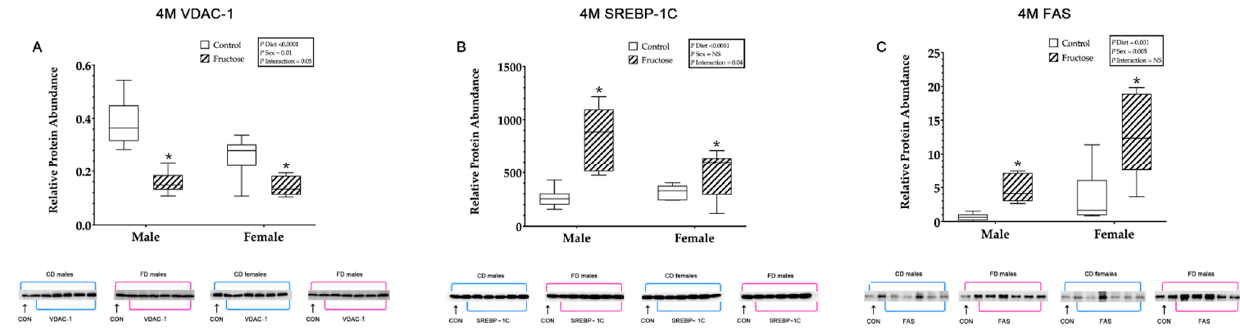
± 52.86 vs. FD males, 764.68 ± 52.86 vs. CD females, 318.25 ± 152.86 vs. FD females, 498.61